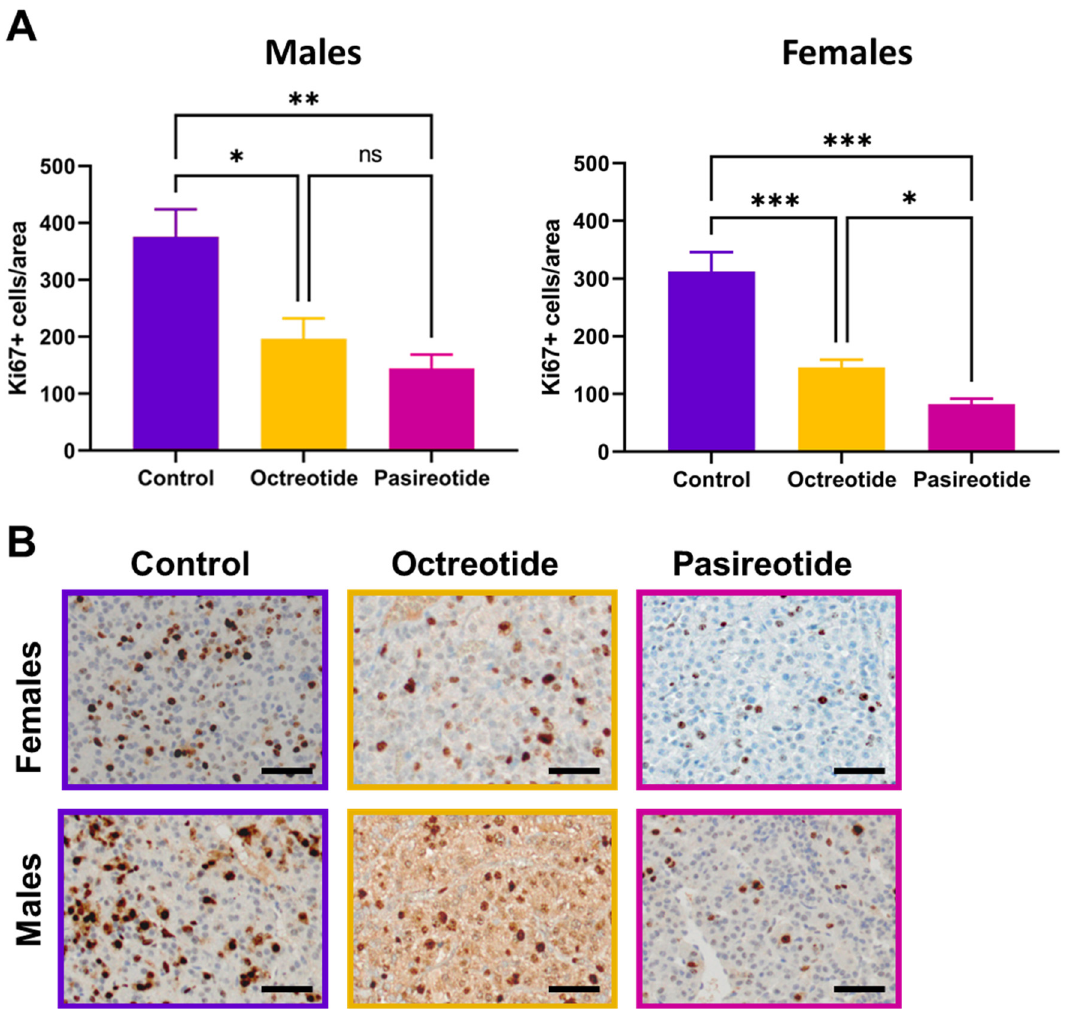
Figure 4. Proliferation of PTs following treatment. ( A ) Number of Ki67-positive cells per 100,000 m 2 in PTs of rats belonging to the three treatment groups and two sexes after 56 d of treatment. Shown is the mean ± SEM. n.s., not significant; *, p < 0.05; **, p < 0.001; ***, p < 0.0001. (by one-way ANOVA) ( B ) Representative immunohistochemical stainings conducted with the anti-Ki67 antibody. Original magnification: ×400. Size bar: 50 µm.